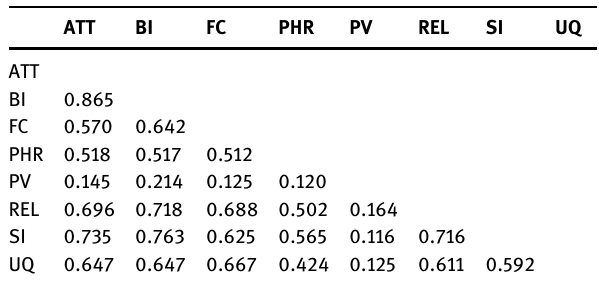
Table 4: HTMT ratio